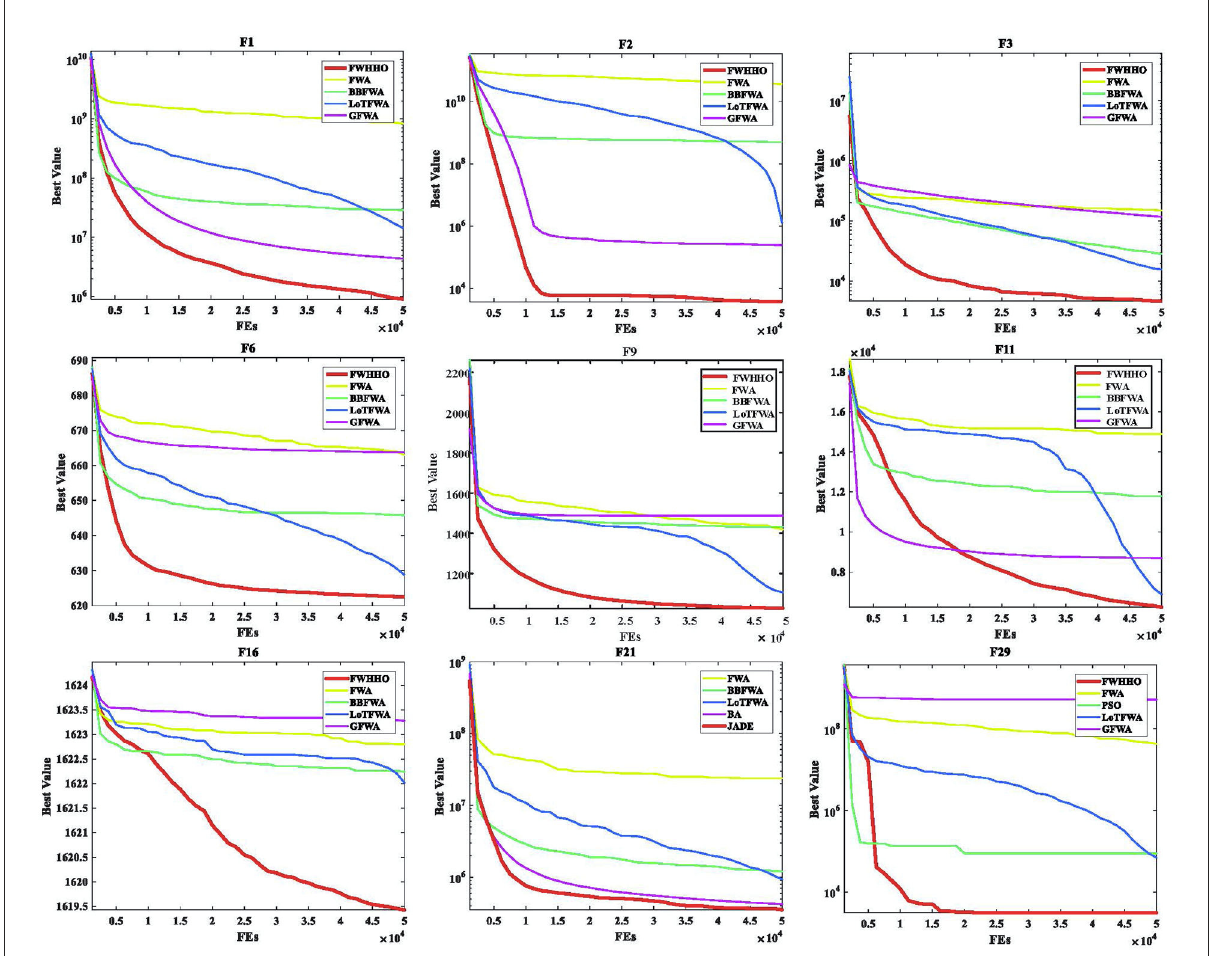
FIGURE2 Convergence curves of FWHHO and existing HHO algorithms.